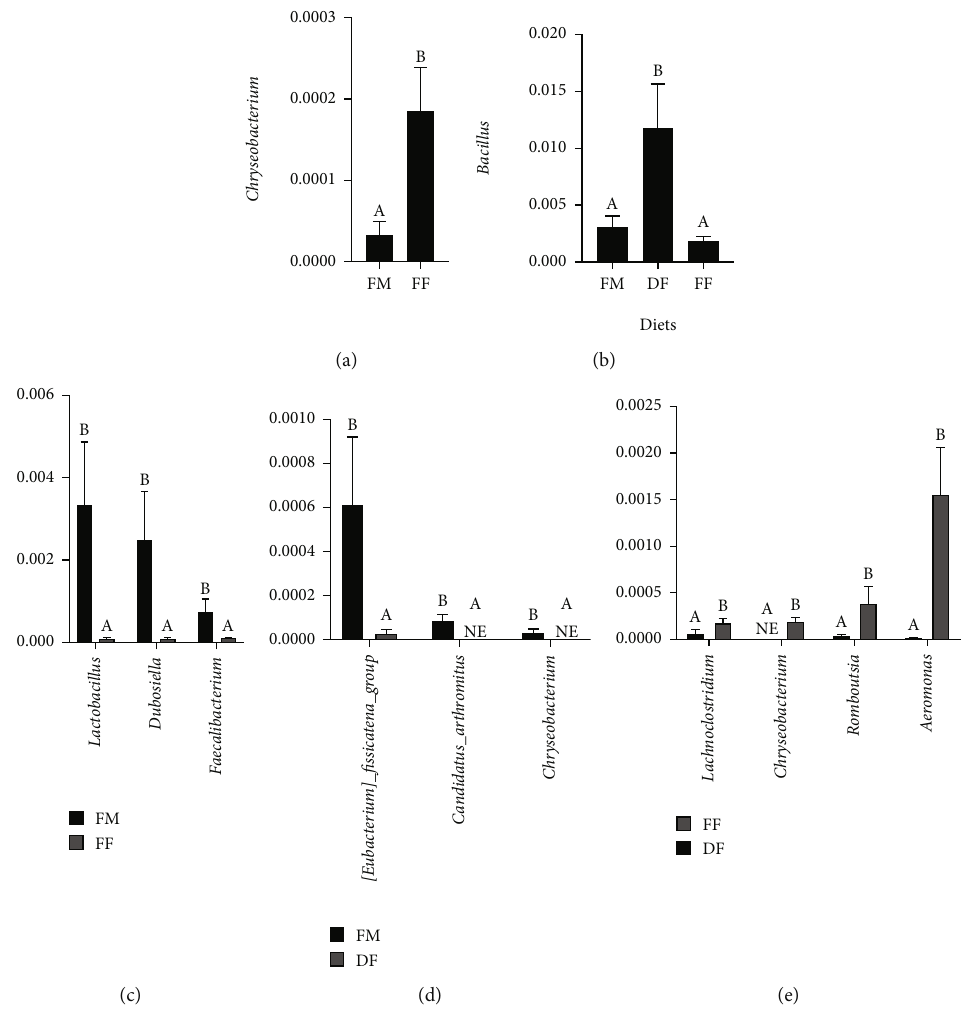
Figure 6: Metastat analysis on the distal intestine of turbot at the genus level. The di ff erent letters on the bar chart represent signi fi cant di ff erences in the mean values ( n = 6 ) between the groups ( P < 0 : 05 ).